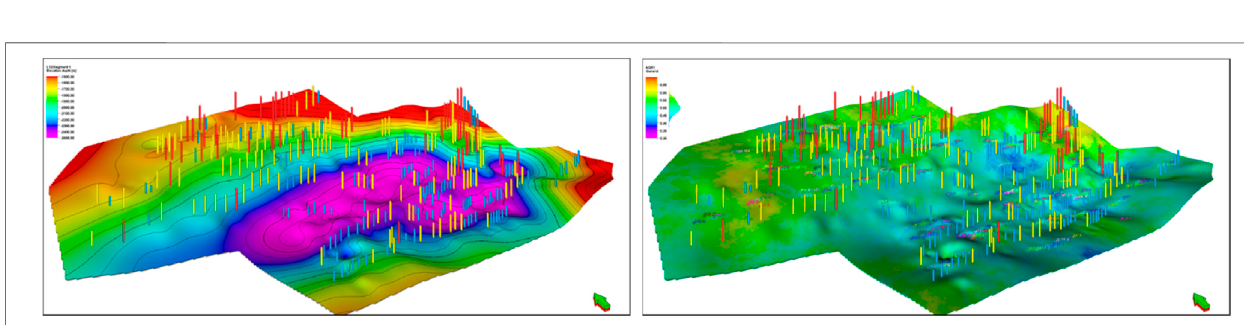
FIGURE 8 | Distribution of gas Wells with different production rates in buried depth contour and M F contour.